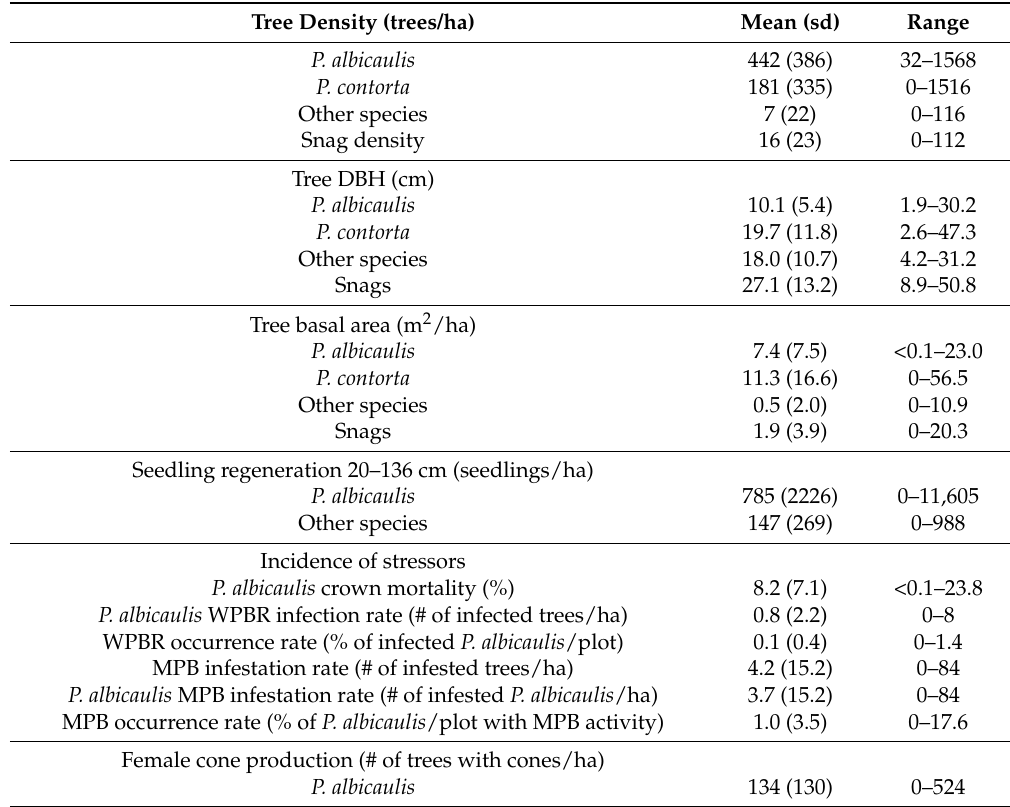
Table 4. Summary statistics of whitebark pine plots measured at Sequoia and Kings Canyon National Parks, CA, USA ( n = 31). DBH = diameter at 1.37 m, WPBR = white pine blister rust, MPB = mountain pine beetle, sd = standard